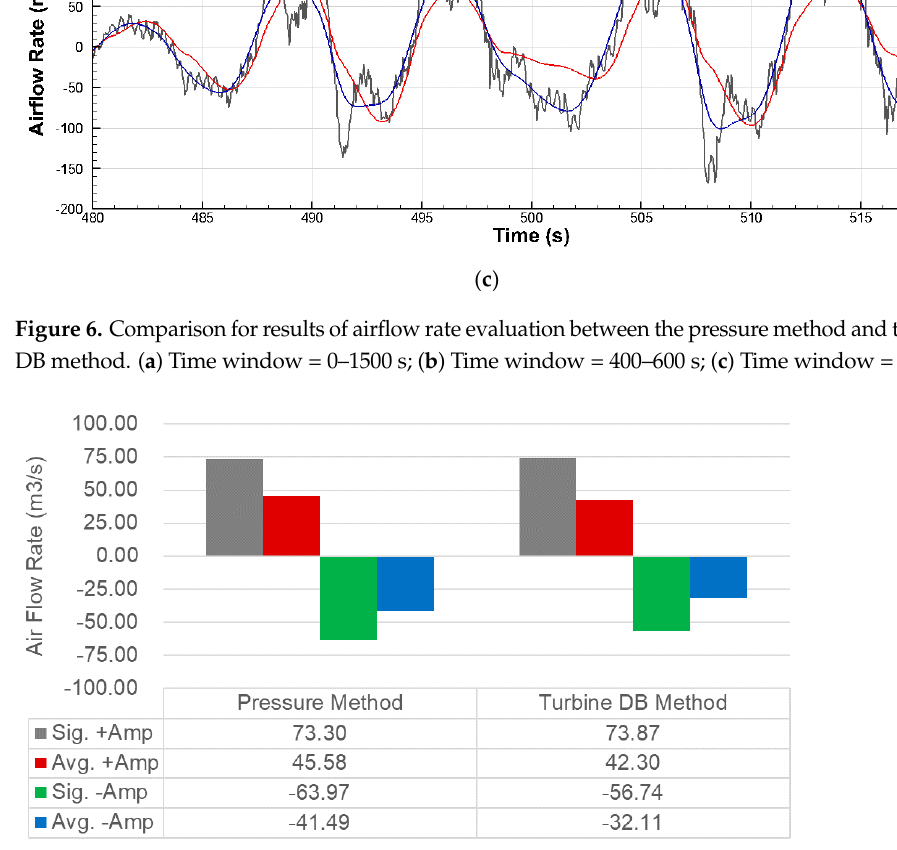
Figure 6. Comparison for results of airflow rate evaluation between the pressure method and the turbine DB method. ( a ) Time window = 0–1500 s; ( b ) Time window = 400–600 s; ( c ) Time window = 480–520 s.